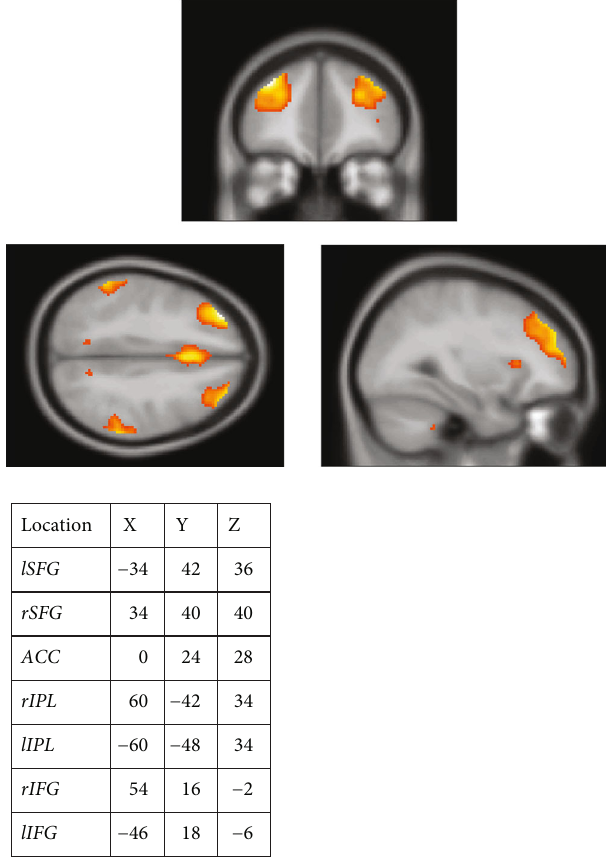
Figure 5: List of selected seeds and their coordinates for the rs-fMRI network analysis. Images decomposed from ICA were used to adjust the seed positions taken from Gao and Lin [36]. Note: lSFG: left superior frontal gyrus; rSFG: right superior frontal gyrus; ACC: anterior cingulum; rIPL: right inferior parietal lobule; lIPL: left inferior parietal lobule; rIFG: right inferior frontal gyrus; lIFG: left inferior frontal